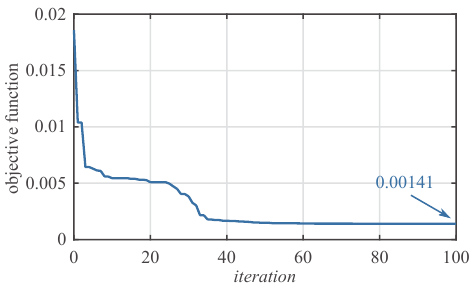
Figure 2. Objective function in iteration domain. Table 3. Values of Q and R matrices obtained for ABC algorithm.